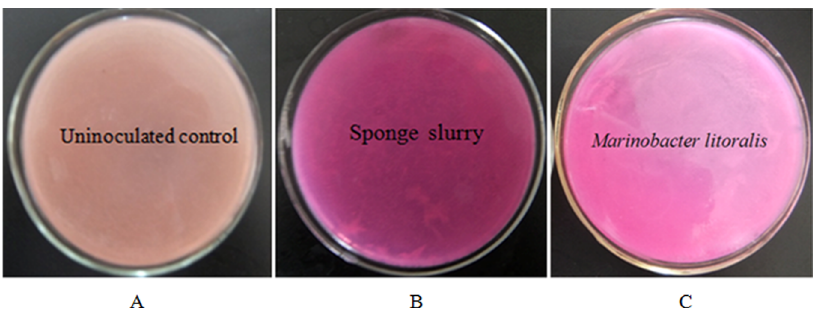
Figure 1. Urease activity of marine sponge X.testudinaria. A: negative control; B: activity of sponge slurry; C: Marinobacter litoralis (bacterium isolated from the sponge).